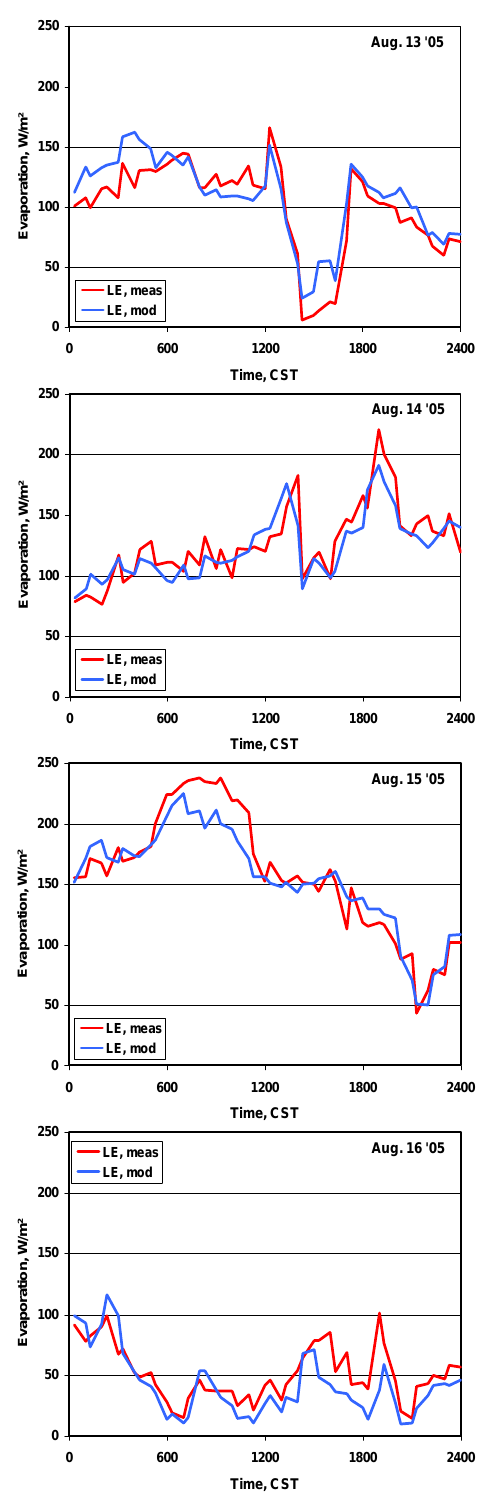
Fig. 7. The measured and calculated half-hourly evaporation rates Figure 7. The measured and calculated half-hourly evaporation rates for 4 consecutive days on for 4 consecutive days on Crean Lake (13–16 August Crean Lake (August 13 – 16, 2005).